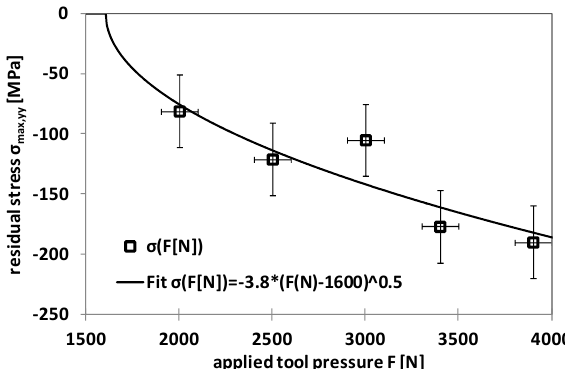
Figure 8. Longitudinal residual stress maximum σ max , yy as a function of the applied force F[N].